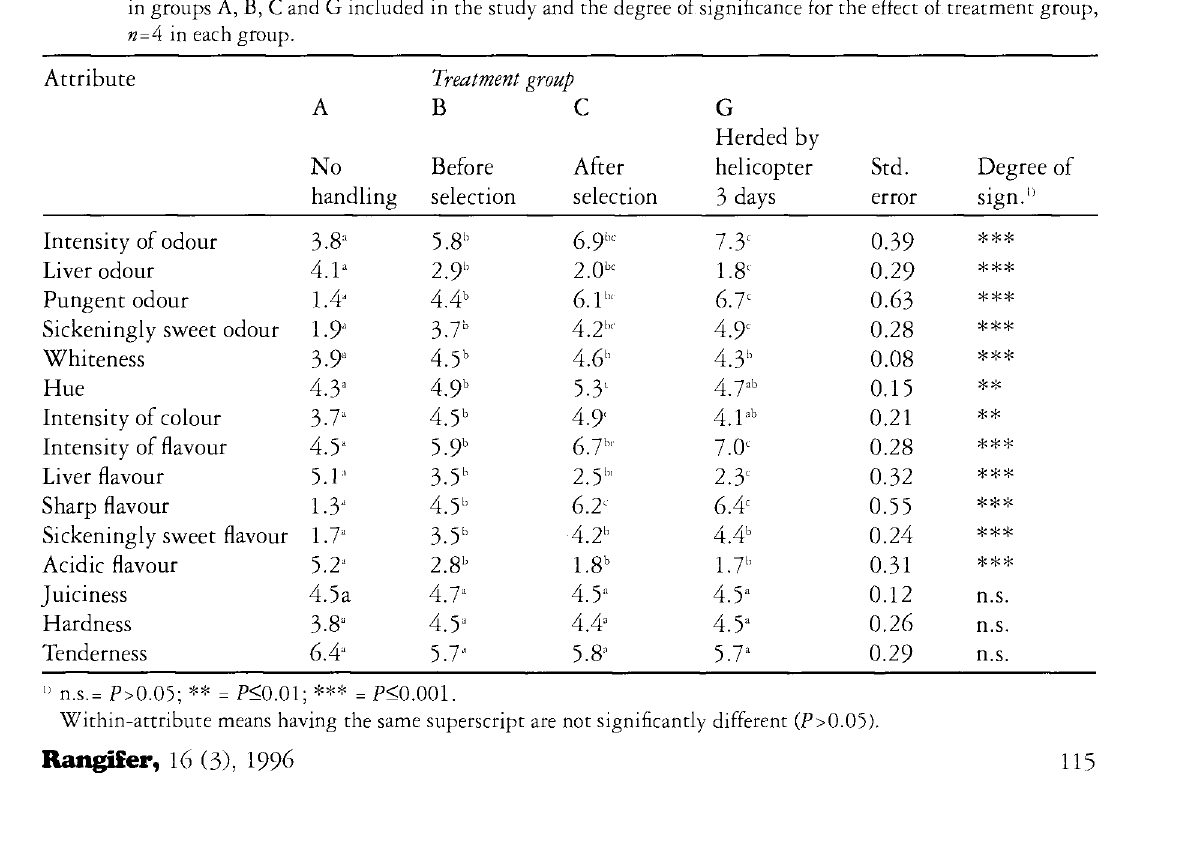
Table 5- Sensory evaluation scores for meat (Al. longissimus) (least-squares means and standard errors) from reindeer bulls in groups A, B, C and G included in the study and the degree of significance for the n = A in each